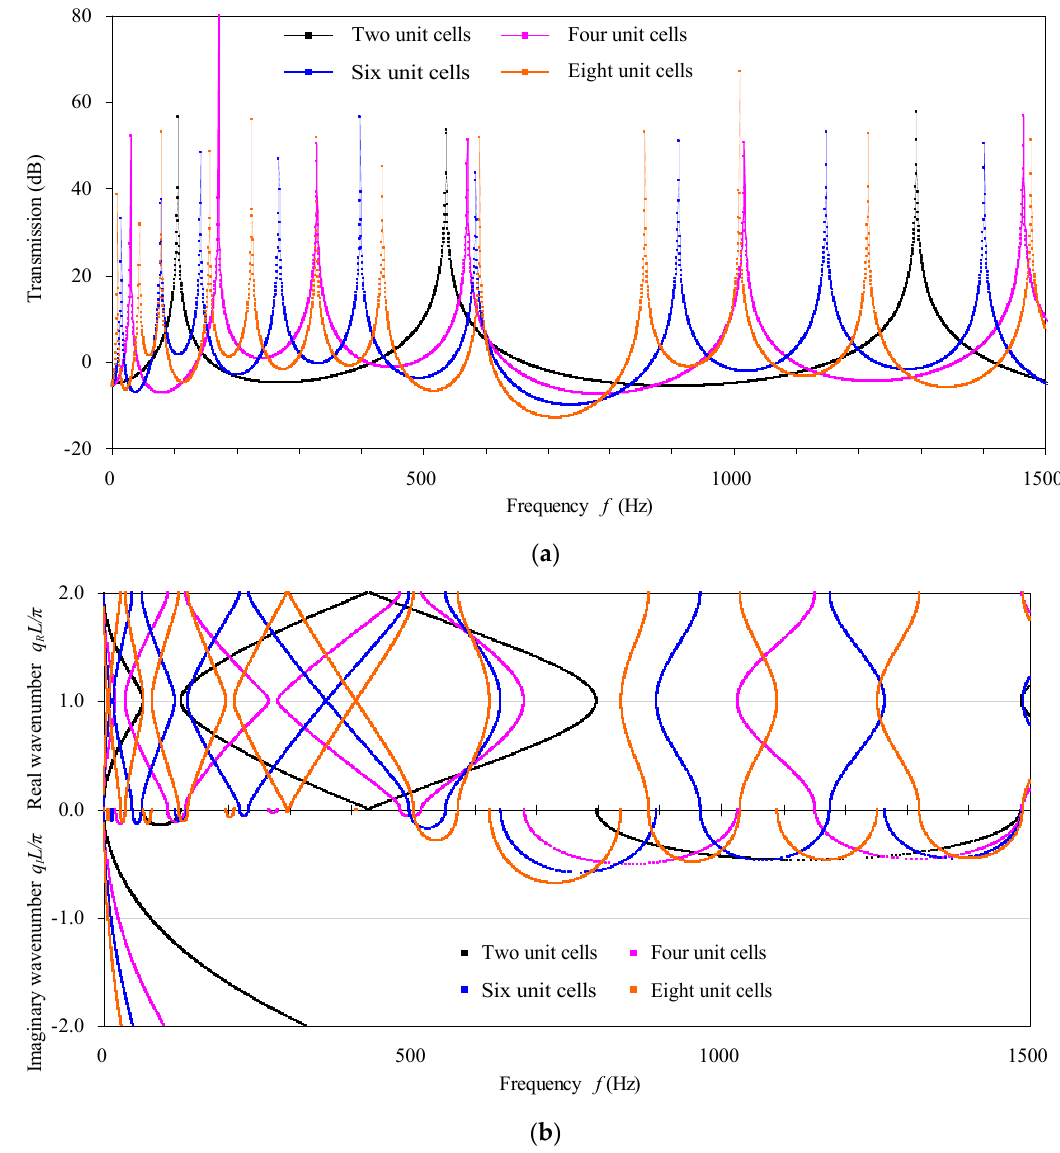
Figure 12. The computed transmission spectra and band structures within f ≤ 1500 Hz of the four defected phononic crystal beams (with two, four, six and eight unit cells): ( a ) The transmission coefficients; ( b ) The phase and attenuation constants spectra.